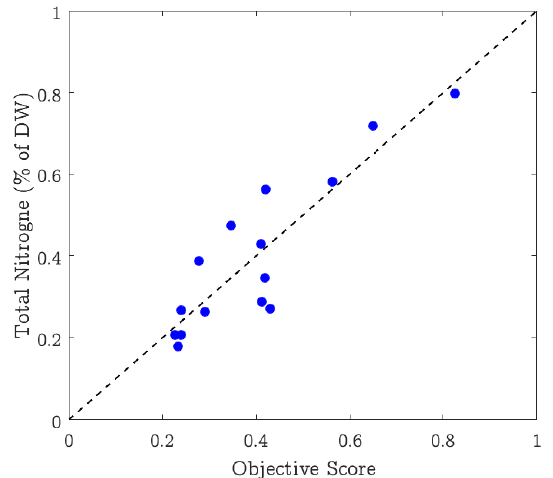
Figure 6. Scatter plot between the nitrogen estimate by the proposed method and the corresponding ground truth values.